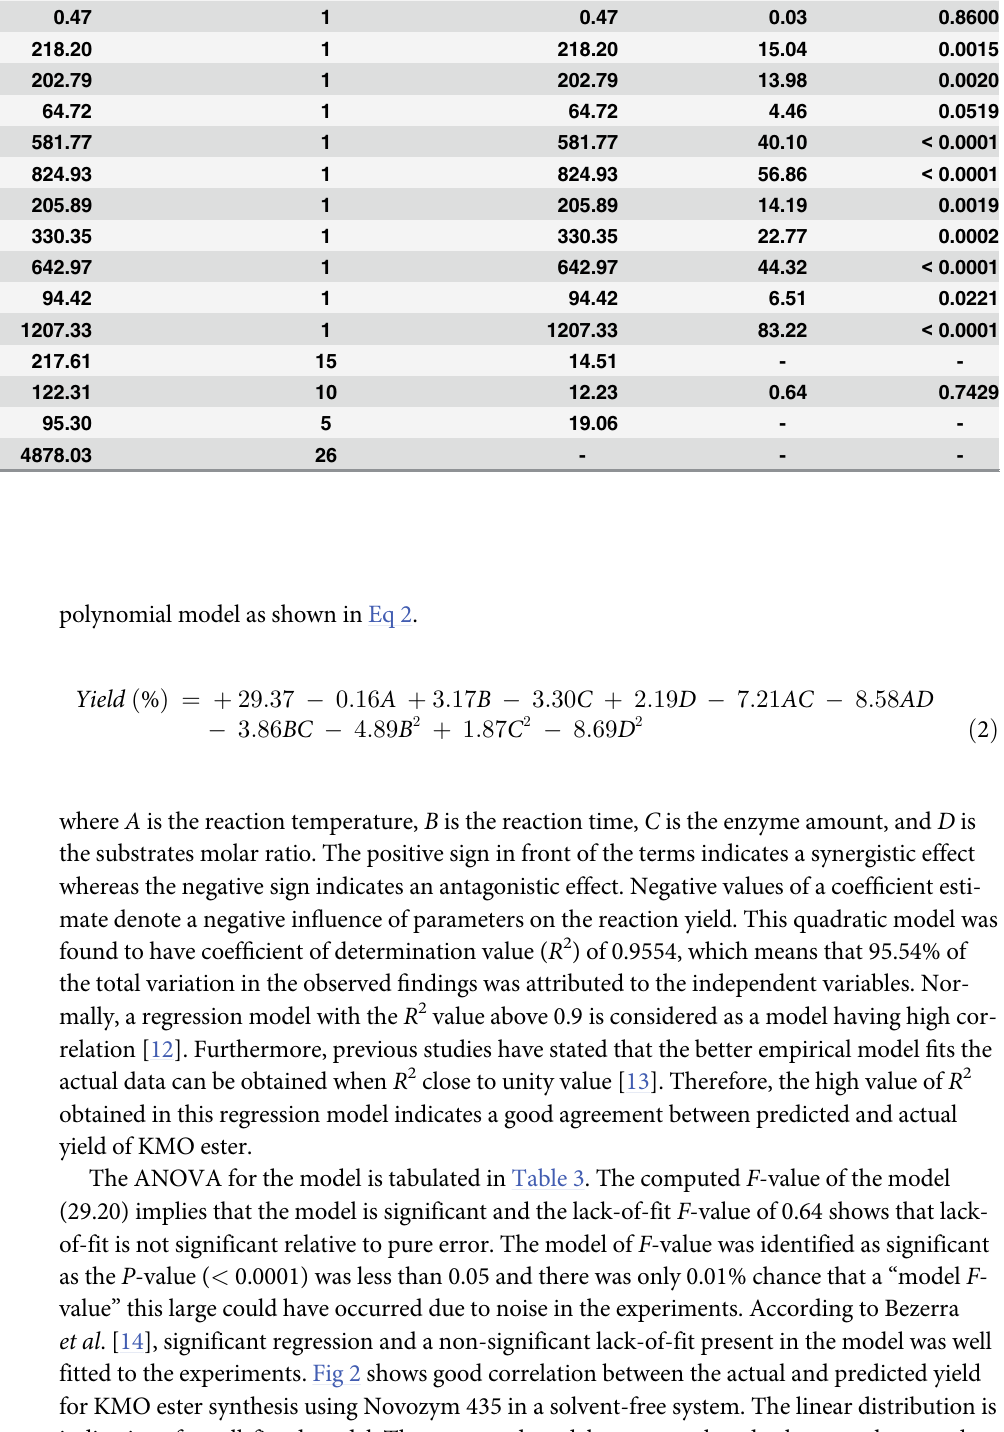
Table 3. ANOVA for the quadratic model developed for synthesis of KMO